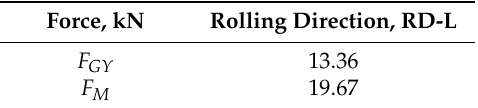
Table 2. Results of force under dynamic conditions at 21.5 ◦ C.